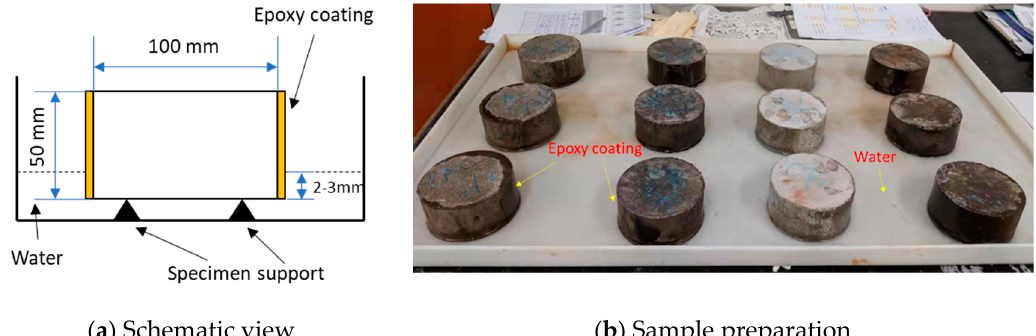
Figure 4 ( a ) and ( b ). Test set-up for sorptivity test. Figure 4. ( a , b ). Test set-up for sorptivity